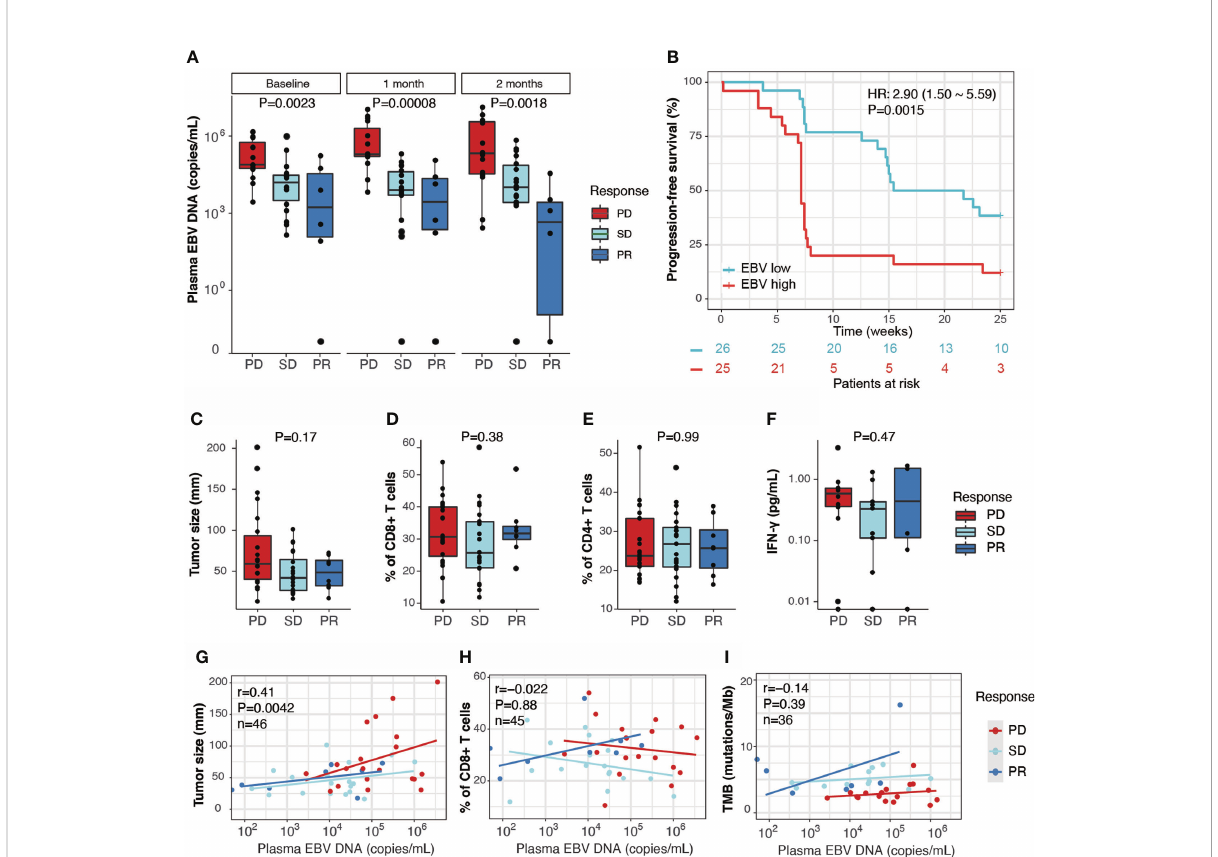
FIGURE 2 Plasma EBV DNA load is associated with response to anti-PD1 immunotherapy in RM-NPC patients. (A) Distribution of plasma EBV DNA copy number quanti fi ed by real-time polymerase chain reaction (qPCR) in PR (n=7), SD (n=19) and PD (n=25) patients. Plasma EBV DNA was assessed before treatment (Baseline) and post-treatment (1 month, 2 months). P values were calculated by using the Kruskal-Wallis test. (B) . Progression- free survival analysis of patients with high plasma EBV DNA (>50,000 copies/mL, EBV high, n=25) and low plasma EBV DNA (<50,000 copies/ mL, EBV low, n=26) at baseline. (C – F) Boxplots showing the distribution of tumor size (C) , % blood CD8+ T cells amongst peripheral mononuclear cells (D) , % blood CD4+ T cells amongst peripheral mononuclear cells (E) , and blood IFN- g (F) in the PD, SD and PR patients before treatment. P values were calculated by using the Kruskal-Wallis test. (G – I) Scatter plots of Pearson ’ s correlation coef fi cients between plasma EBV DNA and tumor size (G) , blood CD8+ T cells (H) and TMB (I) , PD, SD and PR patients were assessed